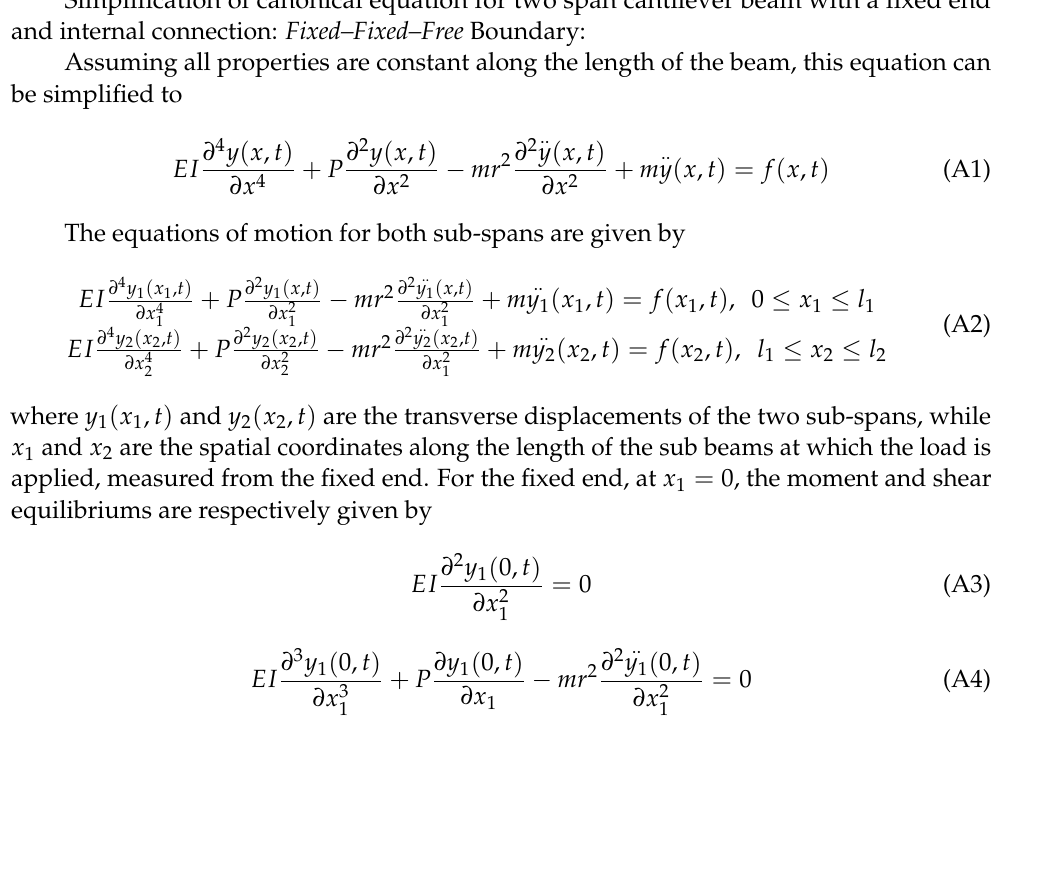
Figure A17. Swept sine inputs: Oscilloscope measurements: Accelerometer 2 .